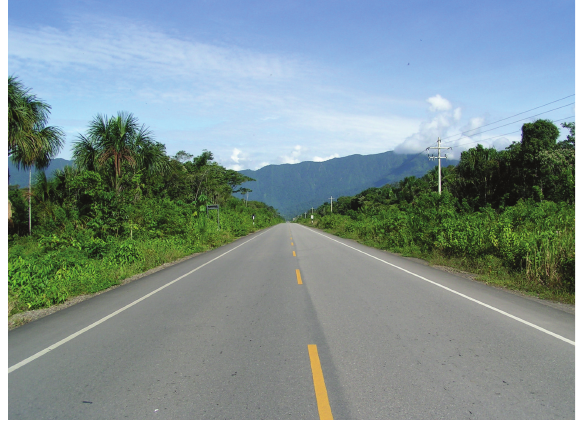
Figure 1: The point where the Andes rise abruptly out of the plain, at 2km west of the Boquer´on,